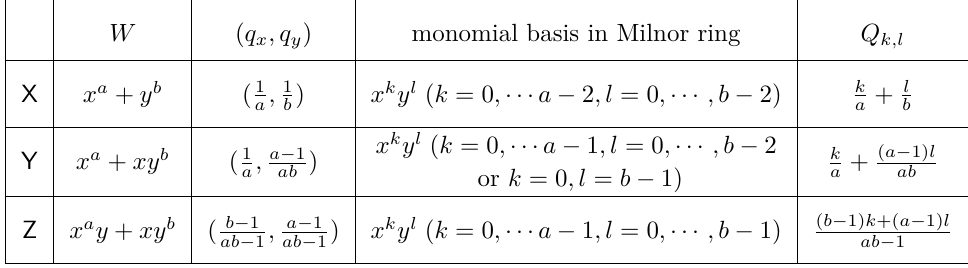
Table 4 . The building blocks of the first six types of singularities. We list the defining polynomials, the weights, the monomial basis in the Milnor ring, and their corresponding Q